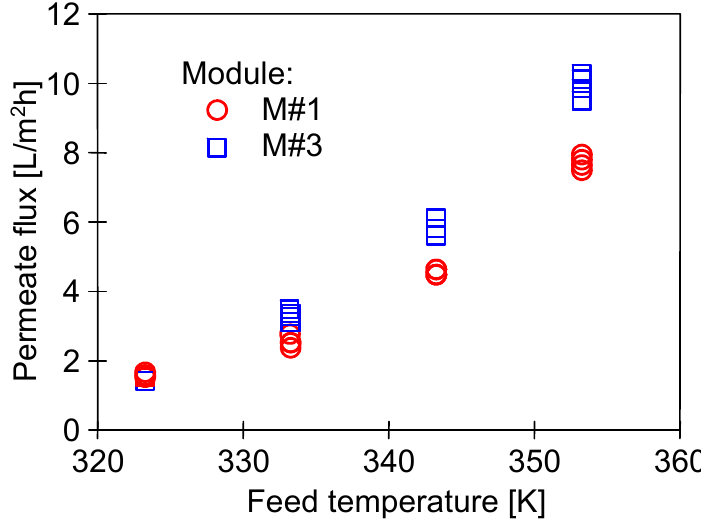
Figure 7. The impact of feed temperature on the permeate flux. Feed: NaCl solution (35 g/L).